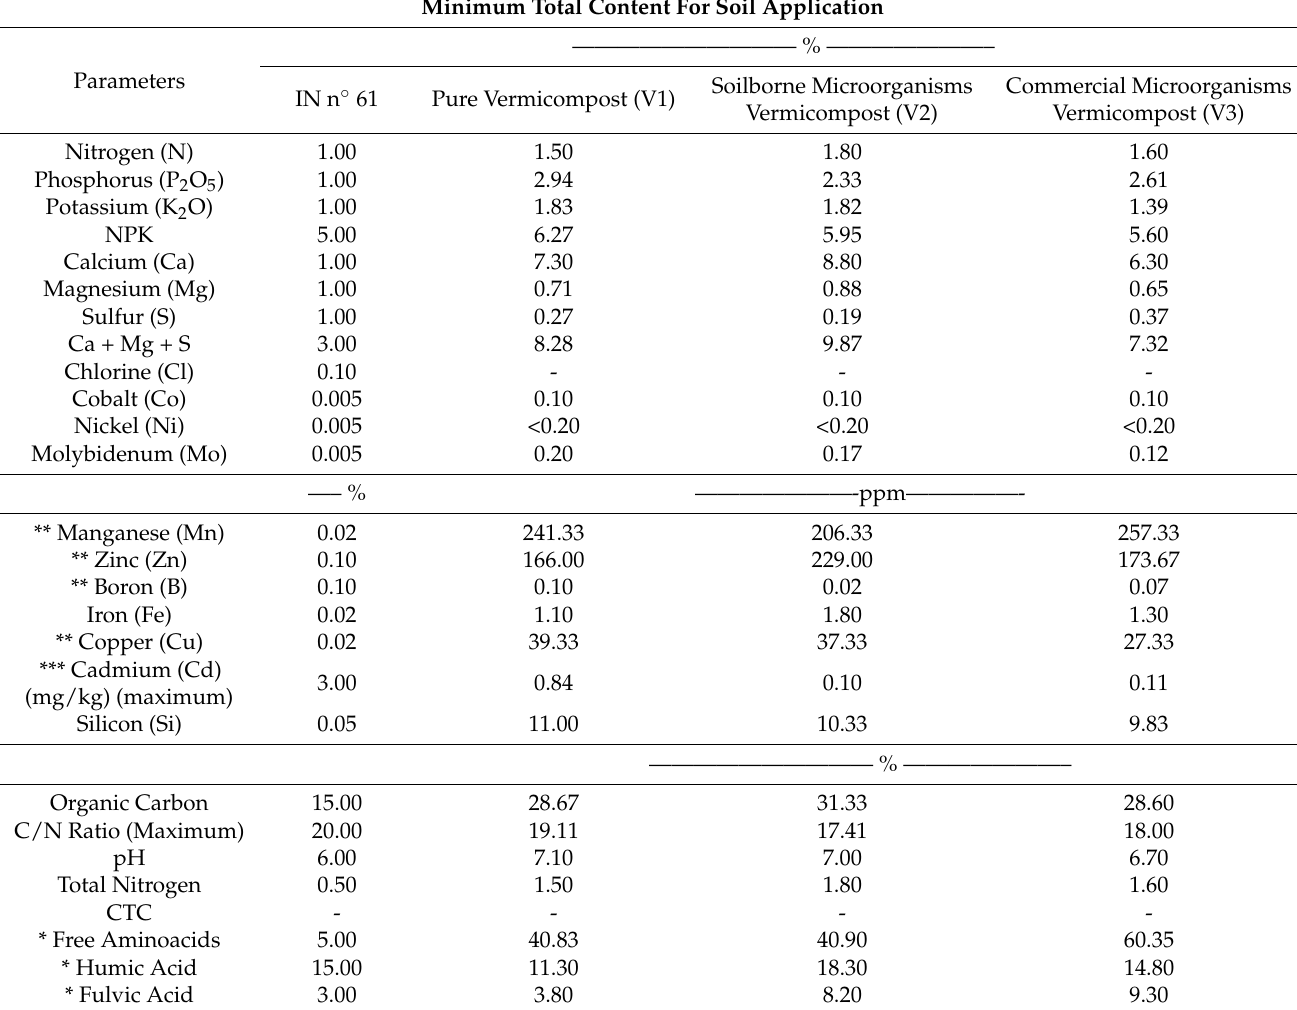
Table 6. Minimum guarantees for products with secondary macronutrients and/or micronutrients for application in soil, leaves, and hydroponics, according to Art. 9 IN No. 61 of 07/08/20